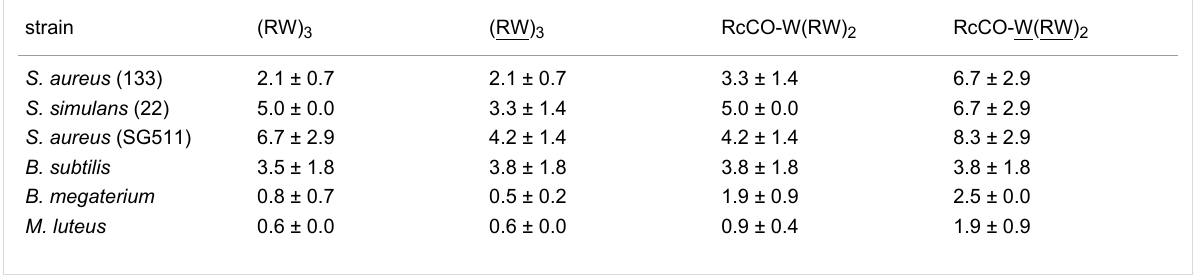
Table 3: Detailed assessment of the MIC values (in µg/mL) of both L- and D-versions of the (RW) 3 and RcCO-W(RW) 2 synAMPs against several Gram-positive bacterial strains. More details on the bacterial strains can be found in the experimental section.